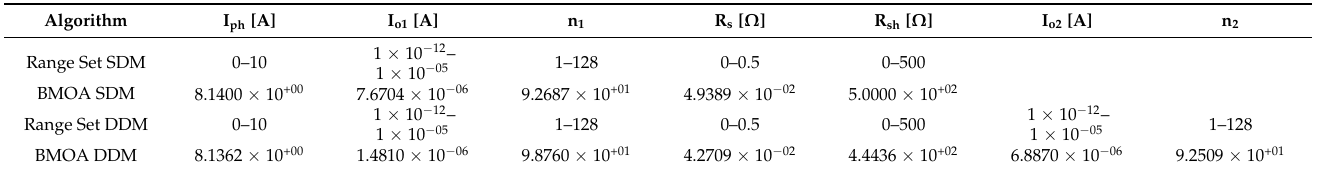
Table 18. Kyocera KC200GT photovoltaic parameters and range.